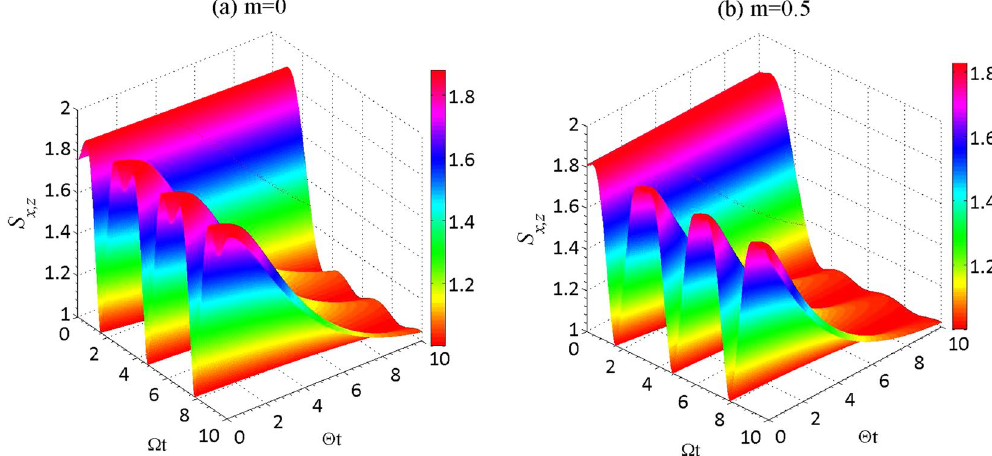
Figure 9. The variation of entropic sum, S , as a function of Θ t and Ω t for different measurement strengths x z , ( m ) with an atomic initial state constructed with θ π = /5 and φ π = /3 . Graph ( a ): = m 0 ; and Graph ( b ): = . m 0 5